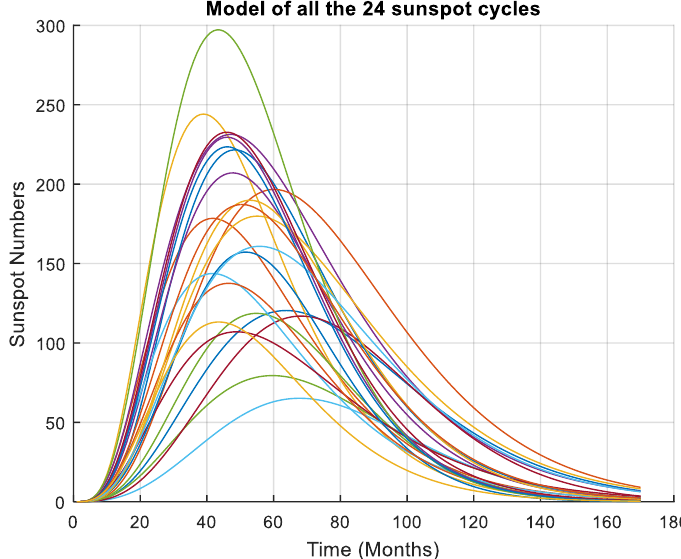
Figure 9. Model of all the 24 Sunspot number